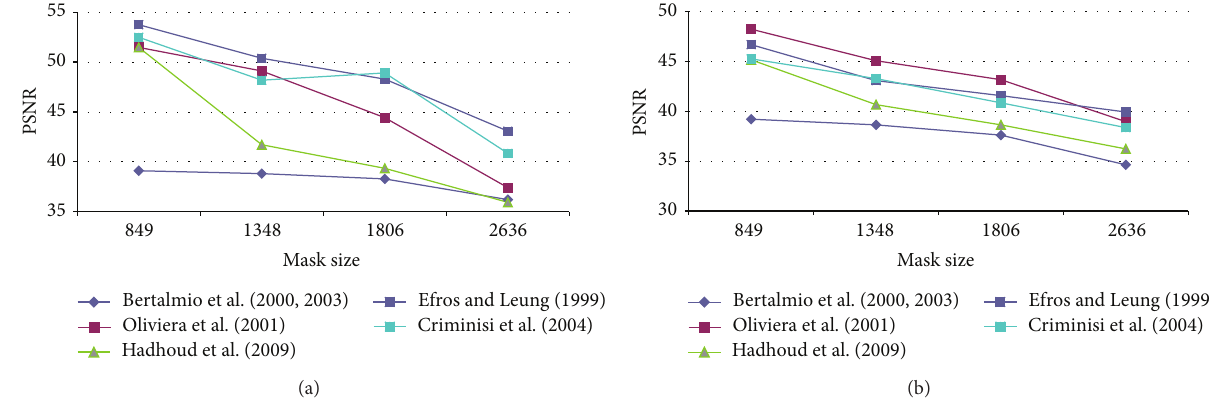
Figure 6: PSNR results for (a) Barbara and (b) Egipt test image.